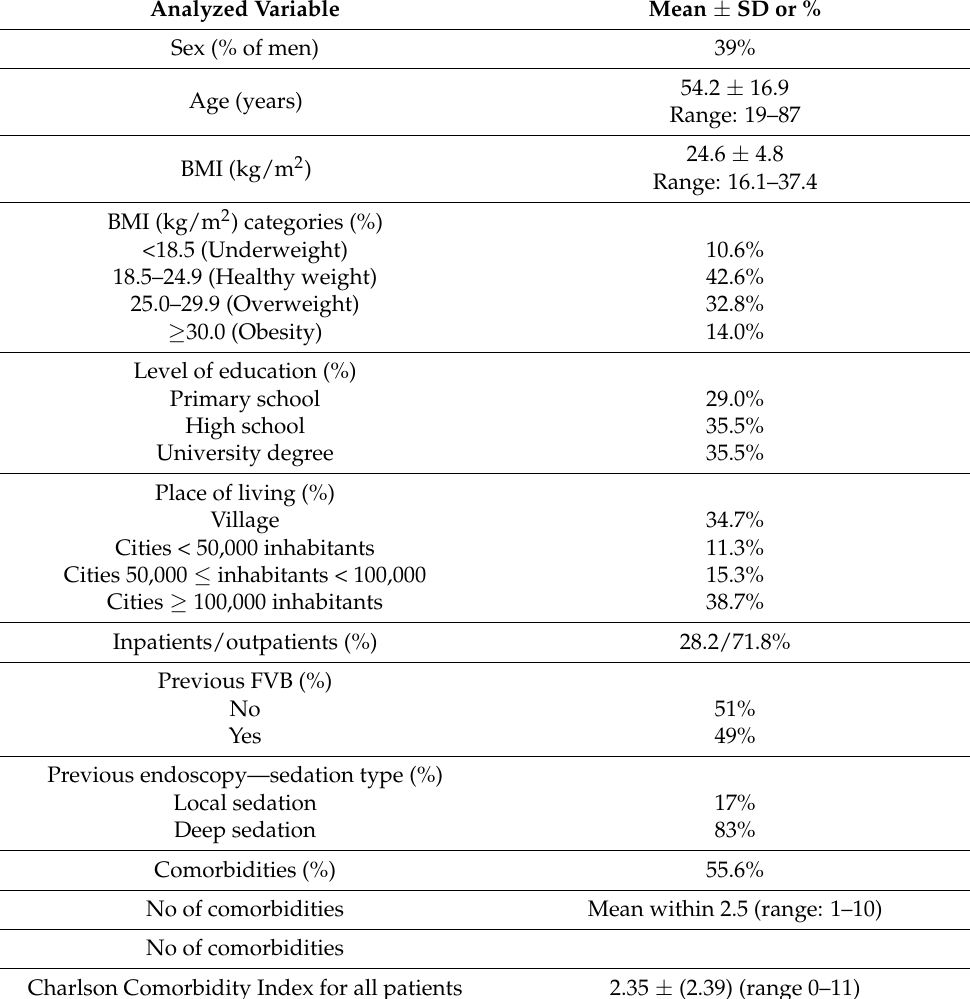
Table 1. The baseline characteristics of the study